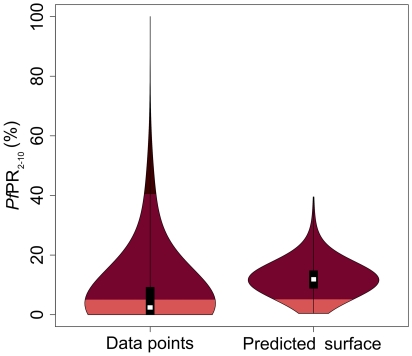
Violin plots showing for each region frequency distributions of PfPR2–10 data.The width of each polygon illustrates the relative frequency of different PfPR2–10 values. The background is coloured to match the endemicity classes shown in Figure 5. The black central bar indicates the inter-quartile range and white circles indicate the median values.